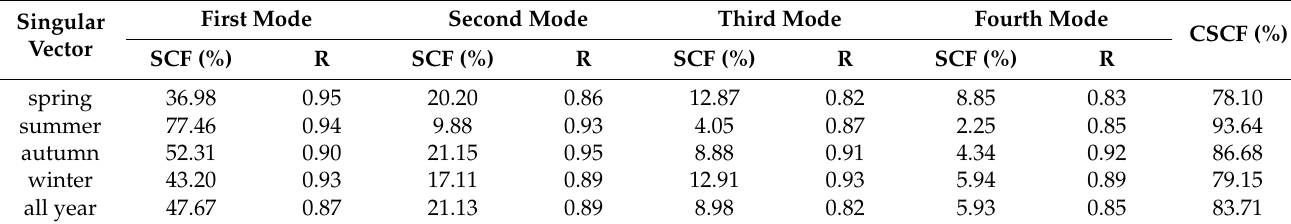
Table 2. SVD results of latent heat field and water vapor flux divergence